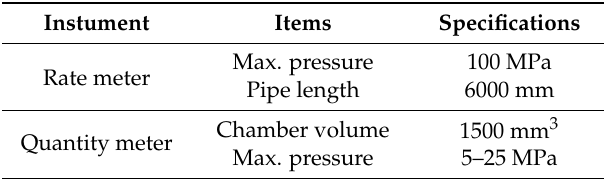
Table 1. Injection rate and quantity meter